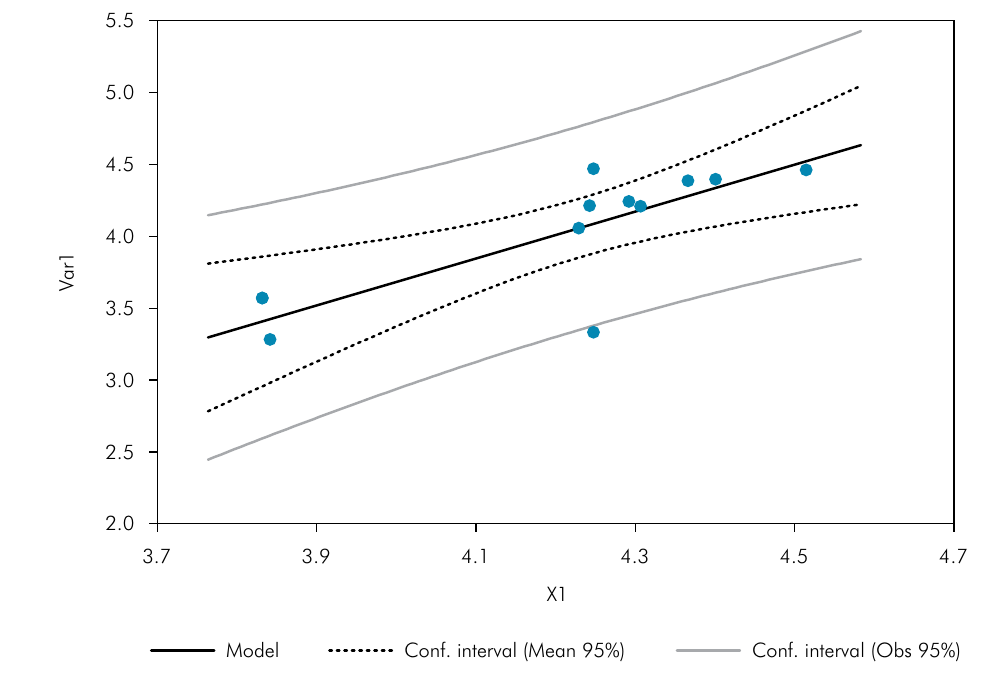
Figure. Regression analysis of students’ satisfaction during the war (Var 1) and students’ satisfaction before the war (X1) (R² =